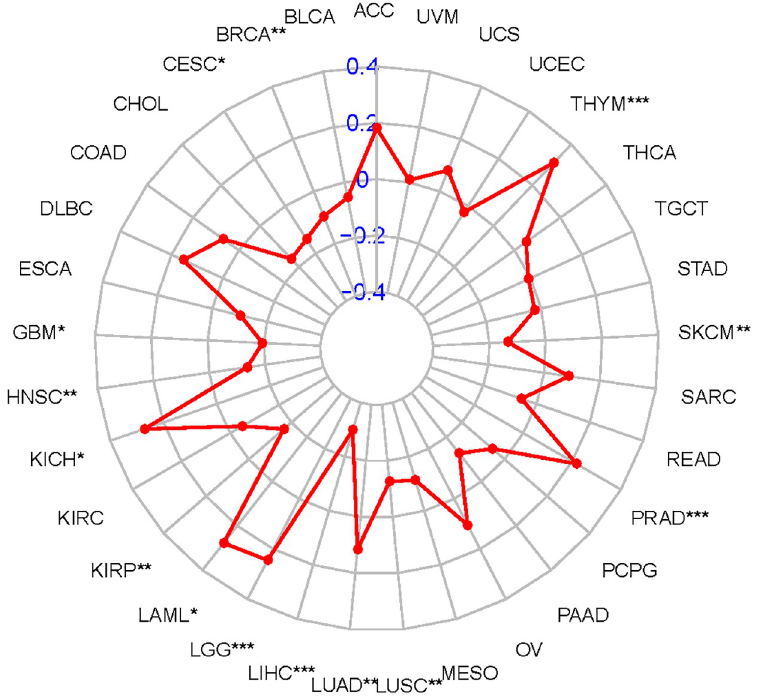
Fig 5. Radar graph for relationship between the expression of COL1A1 and TMB of each tumor sample. Correlation between Tumor mutational burden and LGG, THYM, PRAD, LUAD, LAML and KICH( � P < 0.05; �� P < 0.005; ��� P <